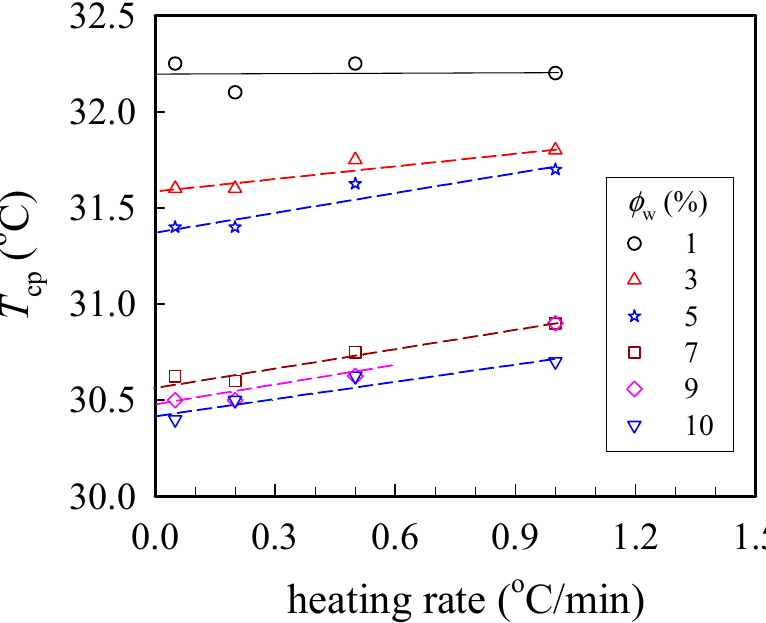
Figure 1. Plots of the cloud point T cp at different heating rates for a-PNIPAM/H 2 O of different concentrations φ w . The binodal temperature was derived from the extrapolated temperature at the zero heating rate.